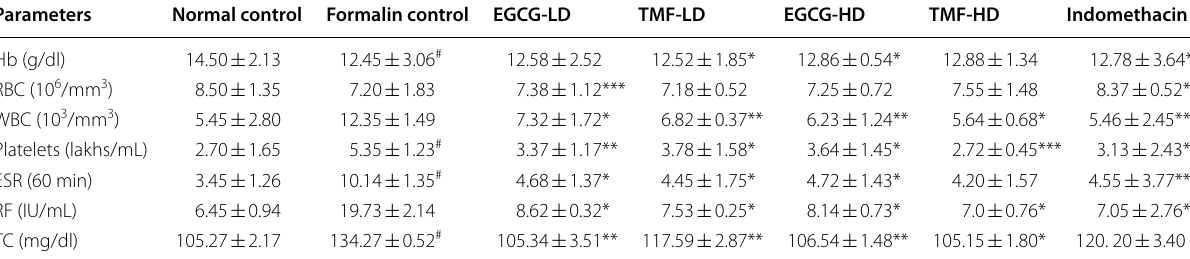
Values are mean S.E.M.; n 6; # p < 0.001 vs normal control group; * p < 0.001, ** p < 0.01, *** p < 0.05 and vs. DSS =